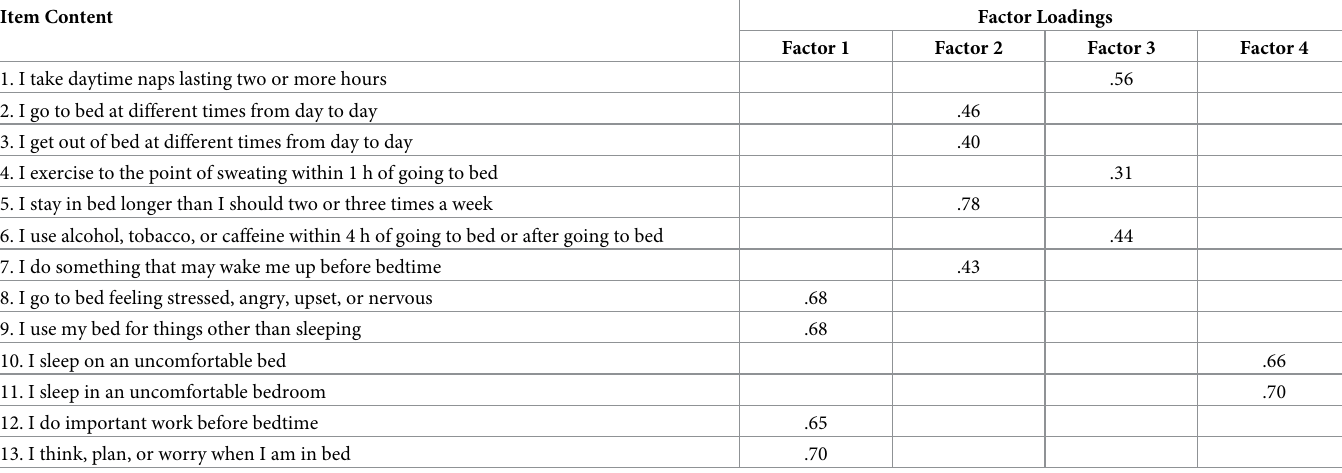
Table 1. Items and factor loadings of the Sleep Hygiene Index